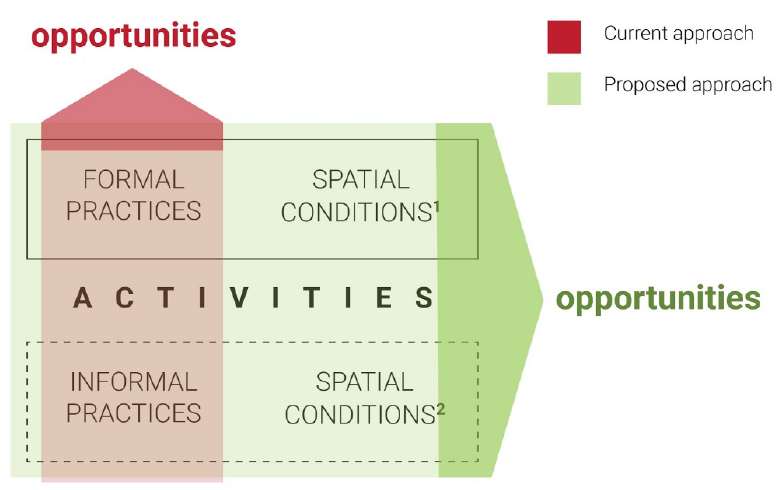
Figure 1. Existing and proposed approaches on socio-spatial segregation. Source: